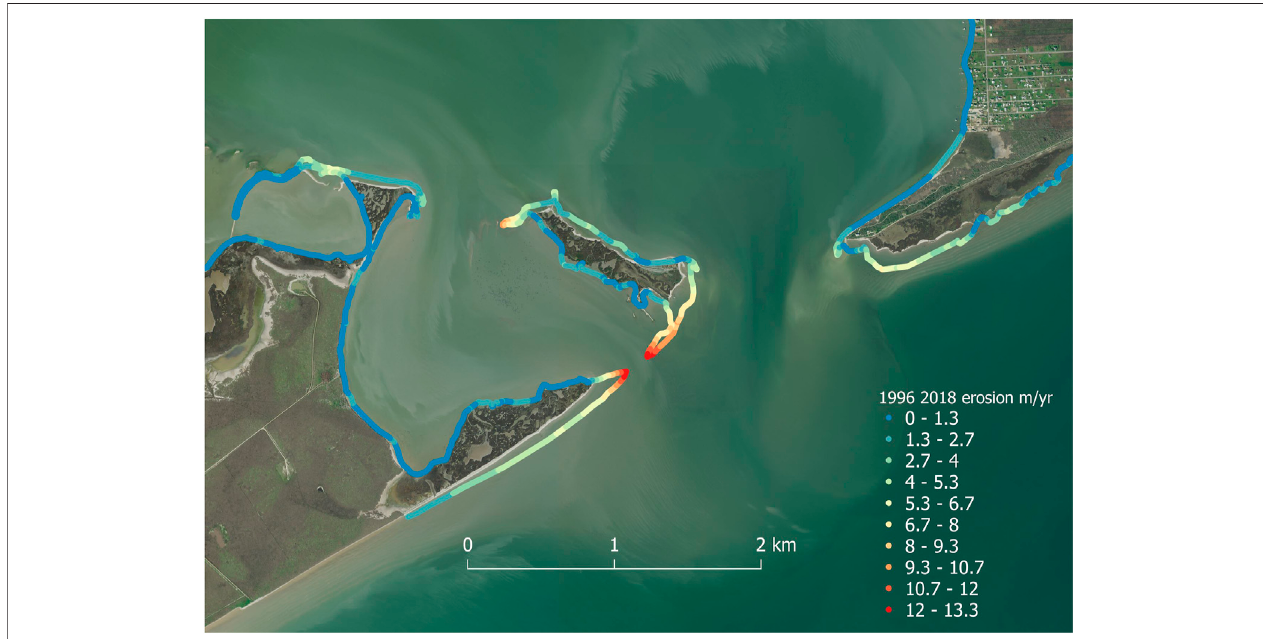
FIGURE 5 | Shoreline retreat rates in the southern portion of Carancahua